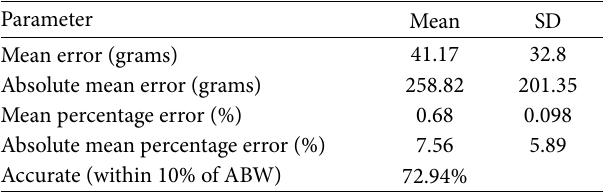
Table 1: Summary of the maternal and fetal variables.